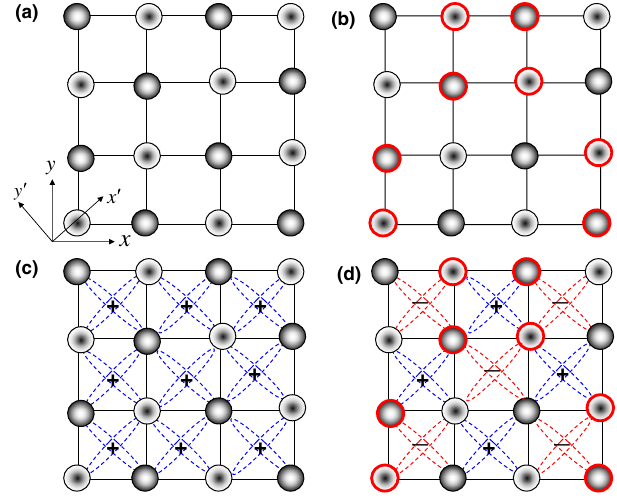
FIG. 1. (a) The square lattice structure of a single iron layer: One cell includes two Fe ions shown as differently filled black balls forming two sublattices. We use x - y coordinates to mark the original tetragonal lattices and x 0 - y 0 to mark the sublattice direction. (b) The gauge transformation is illustrated. The balls with red circles are affected by the gauge transformation. (c) and (d) The mapping from the s -wave to the d -wave pairing symmetry by the gauge